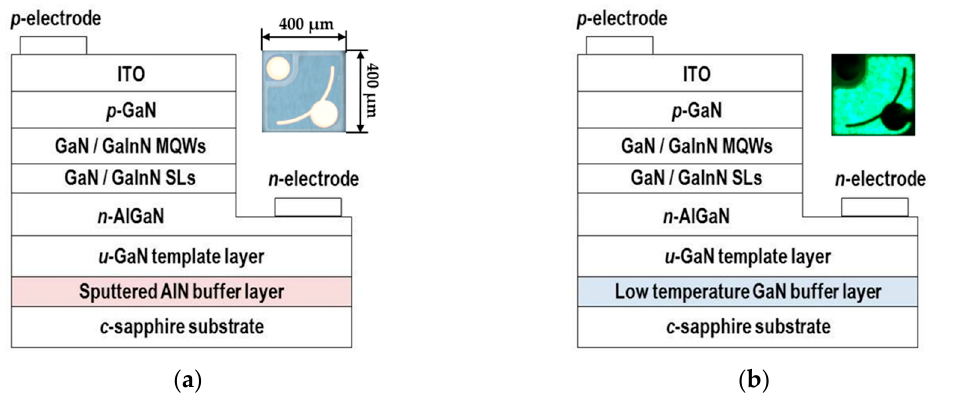
Figure 1. Schematic illustrations of ( a ) GaInN-based green light-emitting diode (LED) with a sputtered-AlN buffer layer (LED A) ( b ) GaInN-based green LED with a conventional LT-GaN buffer layer (LED B). The inset of Figure 1a is the top-view image of both samples and the inset of Figure 1b is the top-view image of electroluminescence (EL) emission for both samples.